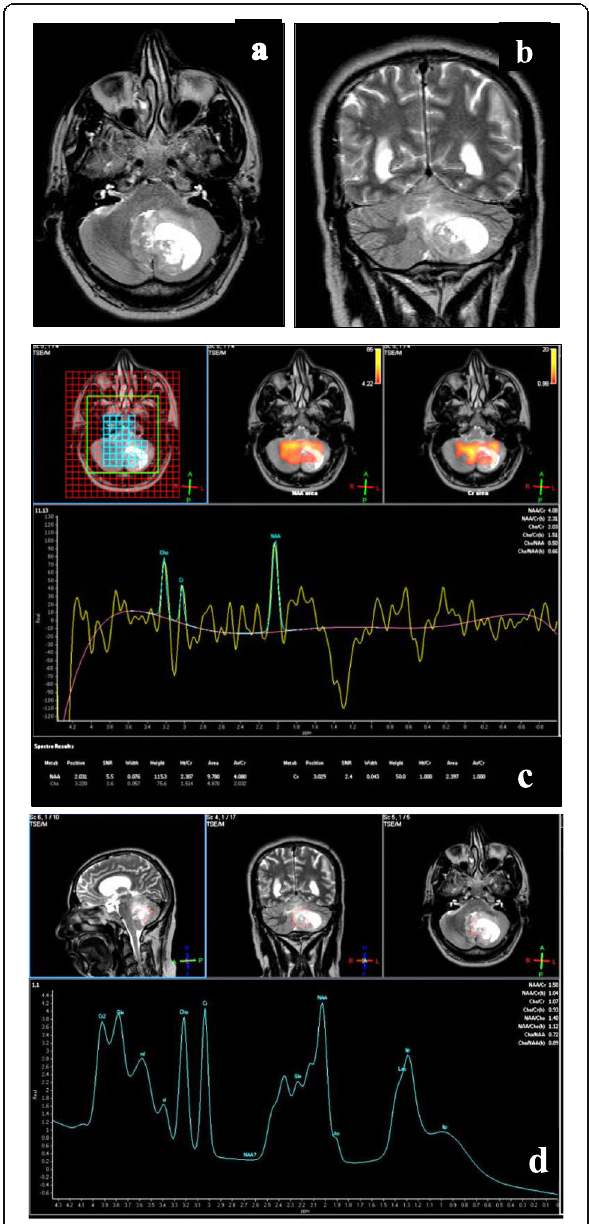
Fig. 1 A 12-year-old male patient presented with headache. a , b Axial and coronal T2WI show a heterogenous hyper intense left cerebellar and vermian SOL with mixed solid and cystic components. c 2D PRESS 144 ms echo spectrum shows mild elevation of choline peak and nearly normal Cr and NAA. The Cho/ Cr ratio = 2, Cho/NAA ratio = 0.5, Cho/NAA+Cr ratio = 1.2, NAA/Cho ratio = 2, and NAA/Cr ratio = 4.1 with inverted lactate peak. d 2D short TE 26 ms echo spectrum shows additional equivocal myo- inositol peak (mI/Cr ratio = 0.72) and a lipid peak. MRS diagnosis: primary low-grade astrocytoma. Histopathologically proved: WHO grade I cystic